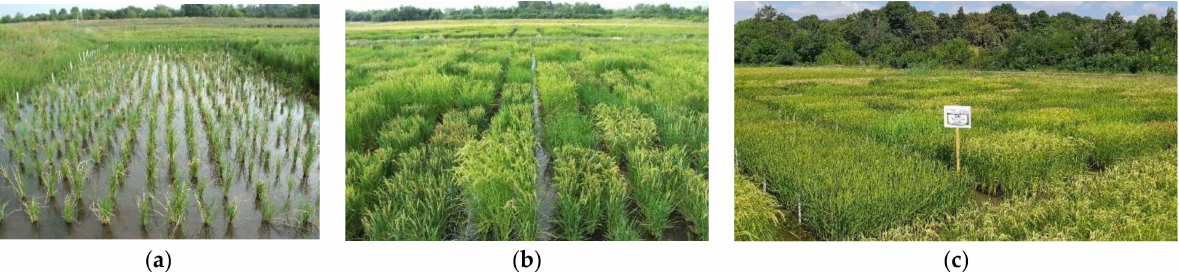
Figure 3. Propagation and evaluation of DH lines in the nursery: ( a ) growing of acclimatized DH 0 plants in field conditions, ( b ) observation of phenotypic and agronomic characters of DH lines (DH 1 ) in micro-plots, ( c ) yield trial experiment of DH lines (DH 2 ) in the small-scale field evaluation